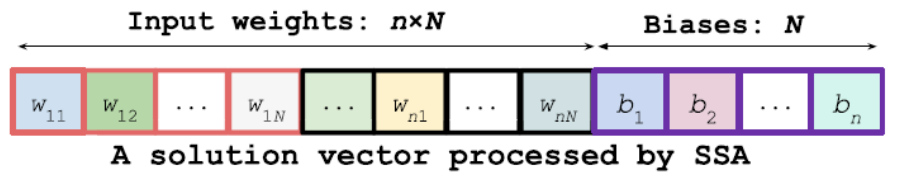
Figure 6. The details of experimental model [33].